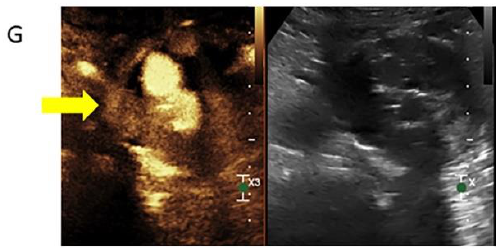
Figure 3. Coronal MIP image ( A ) demonstrating an infrarenal AAA in a 78-year-old male obtained prior to endovascular repair. Calcific atherosclerotic plaque and vessel patency well-demonstrated on this arterial phase CTA. 100 mL of Omnipaque 350 contrast was administered with CTDIvol of 7.68 mGy. Arterial phase source axial image ( B ) from a CTA demonstrating endovascular repair of the infrarenal AAA with persistent contrast flow into the excluded aneurysm sac, consistent with an endoleak. Sagittal ( C ) and coronal ( D ) MIP images are also shown. Lack of dynamic imaging limits classification of the type of endoleak; although, it was initially characterized as a type II endoleak by CTA. 100 mL of Isovue 370 contrast was administered with CTDIvol of 5.77 mGy. Subsequent contrast-enhanced ultrasound (CEUS, ( E )) with dynamic contrast enhancement demonstrated a type III endoleak arising from the origin of the left iliac limb (( F ), yellow arrow). The type III endoleak represents the major component and a large portion of the bolus empties into the aneurysm sac (( G ), yellow arrow) with a small type II contribution arising from a right lumbar artery (not shown). Three boluses totaling 5 mL of Lumason were injected.